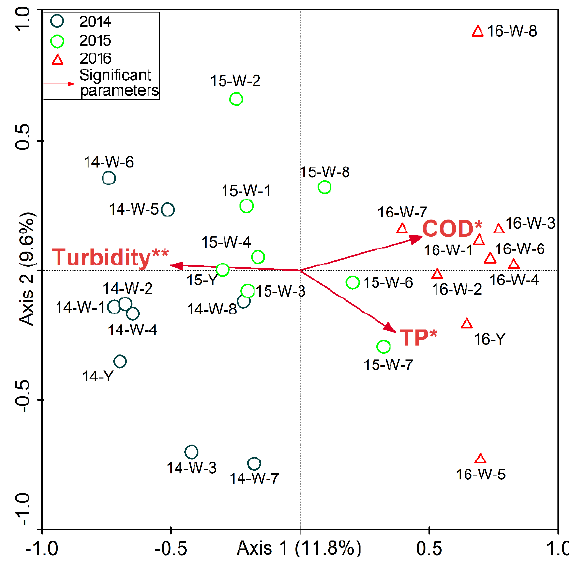
Figure 7. The biplot of the redundancy analysis among sensitive physicochemical parameters and phytoplankton communities in the winter of different years in the Wangyu River channel. COD, permanganate index; TP, total phosphorus. The asterisk marked behind the physicochemical